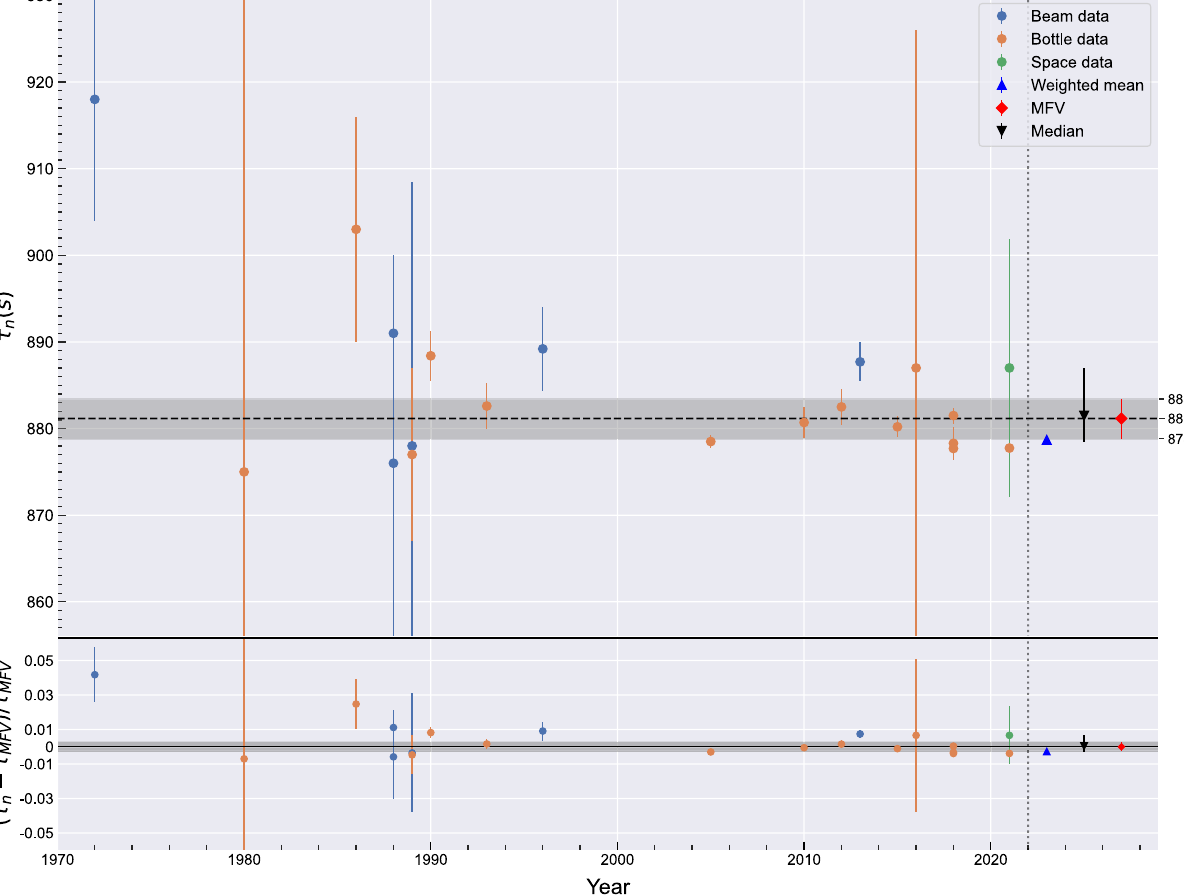
depicttheweightedmean,MFV,andmedian,respectively.(Bottom)We show the residuals of fit or data with respect to the MFV as a function